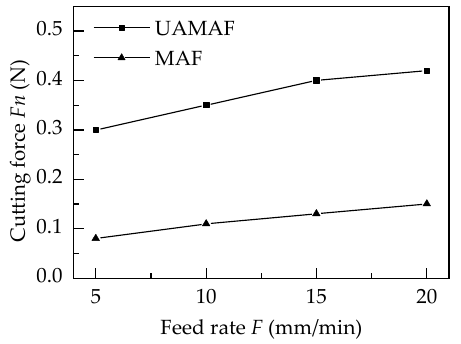
Figure 9. The relationship between feed rate and cutting force.